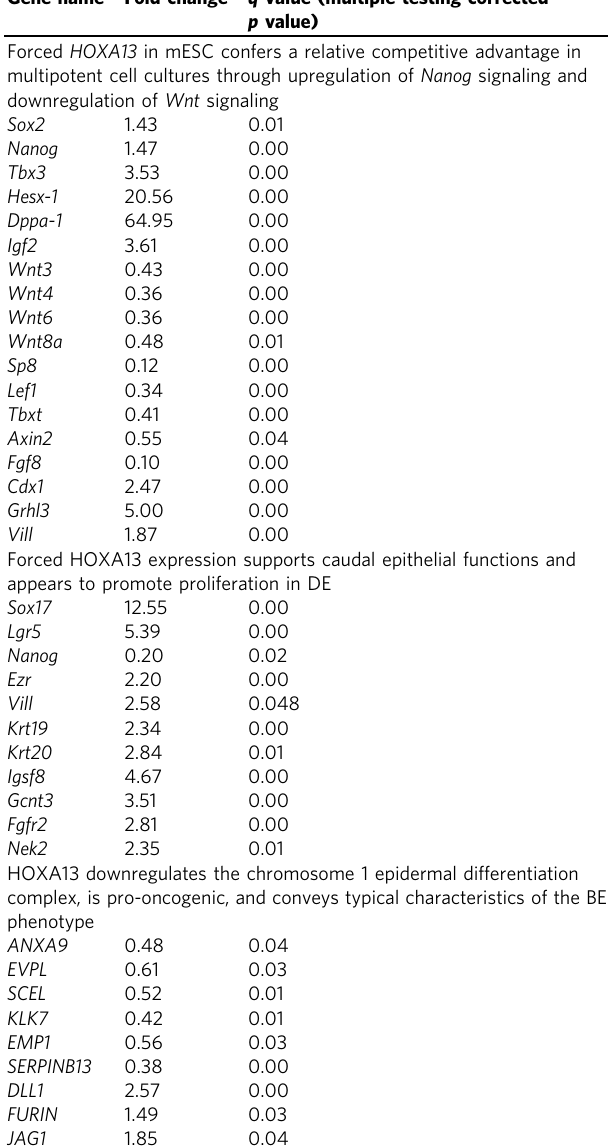
Table 1 Fold changes and q-values for the mRNAs mentioned in the results section of the main text pertaining to cell culture models analyzed by